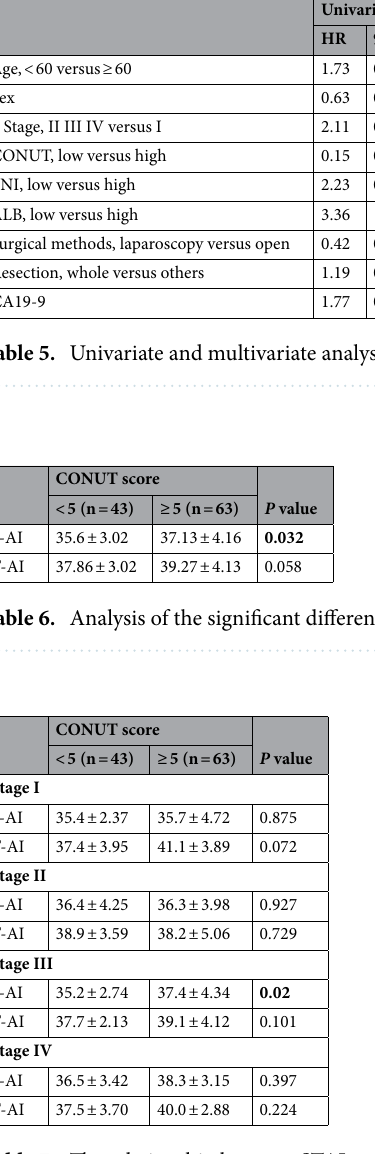
Table 7. The relationship between STAI and CONUT scores in the hierarchical analysis of tumor stage.